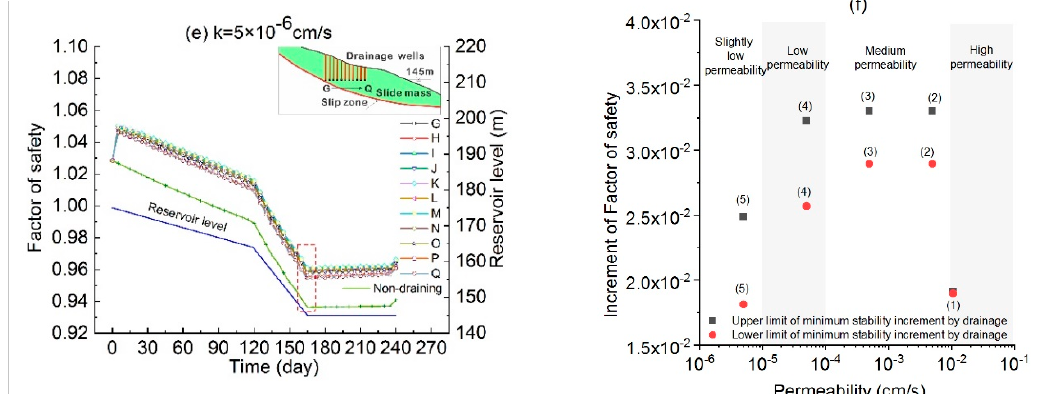
Figure 13. Variation of the stability of landslide with different permeabilities representing different material, under the condition with permeability ( a ) k = 1.06 × 10 − 2 cm/s; ( b ) k = 5 × 10 − 3 cm/s; ( c ) k = 5 × 10 − 4 cm/s; ( d ) k = 5 × 10 − 5 cm/s; ( e ) k = 5 × 10 − 6 cm/s. The relationship of increment of factor of safety and permeability are shown in ( f ). Stability of landslide of different permeabilities with the drainage wells at various positions ( a – e ). The increment of the minimum stability by comparing the drainage and non-draining conditions at the worst situation ( f ) as shown in the red rectangle in ( a – e ). The effect of drainage on the stability improvement varied from different permeable landslides.